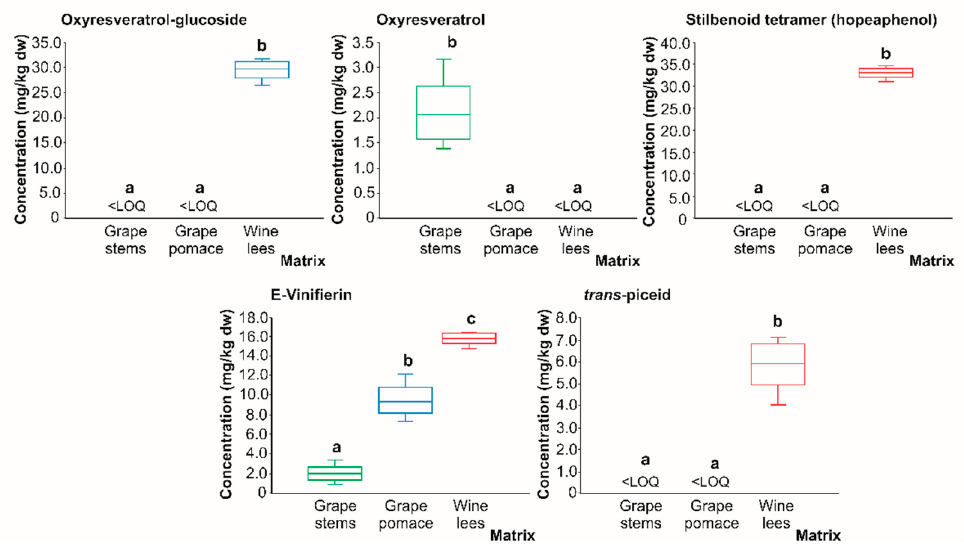
Figure 8. Box plots with quartiles (upper values 75%, median 50%, and lower values 25%) of individual stilbenes (mg/kg dw) of (poly)phenolic extracts of grape stems (green box), grape pomace (blue box), and wine lees (red box). Boxes with a different letter (a,b,c) within each plot indicate statistically significant differences ( p < 0.05) according to the one-way analysis of variance (ANOVA) and Tukey’s multiple range test. <LOQ, lower than the limit of quantification.